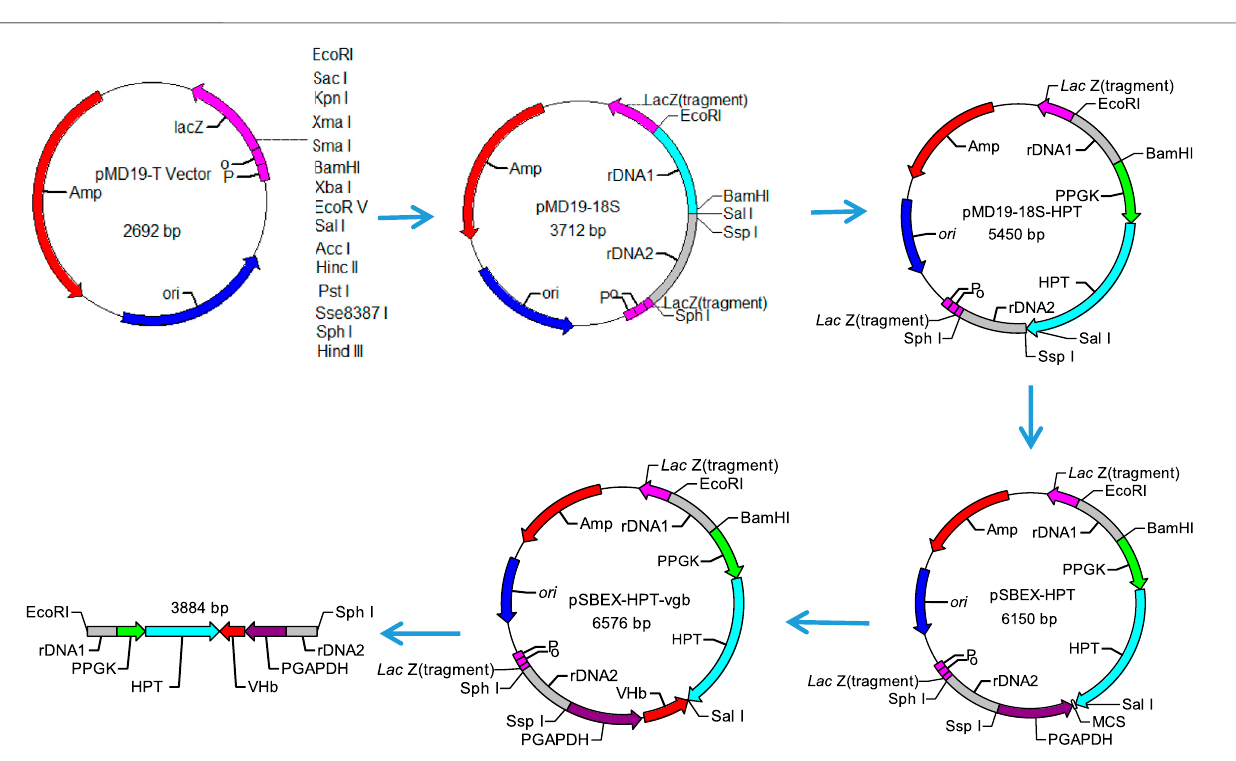
Frontiers in Bioengineering and Biotechnology |